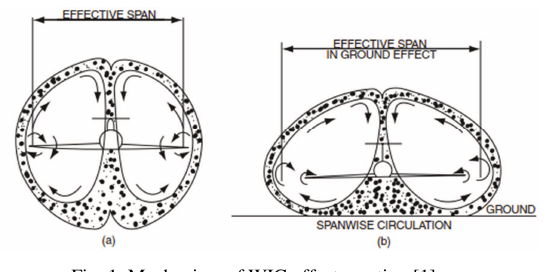
Fig. 1. Mechanism of WIG effect creation [1]